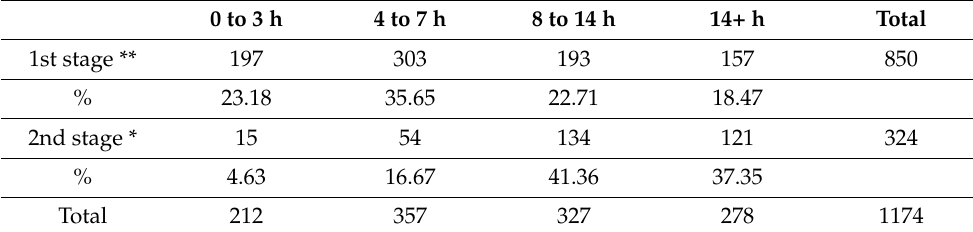
Table 8. Pupils’ responses to the question “How many hours a week do you spend on your mobile phone or communicating on social media?” before and after situation caused by COVID-19. 0 to 3 h 4 to 7 h 8 to 14 h 14+ h Total 1st stage ** 197 303 193 157 850 % 23.18 35.65 22.71